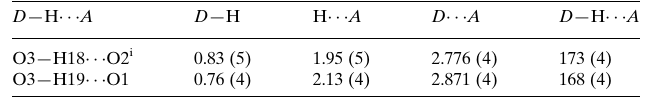
Hydrogen-bond geometry (A˚ , (cid:3)